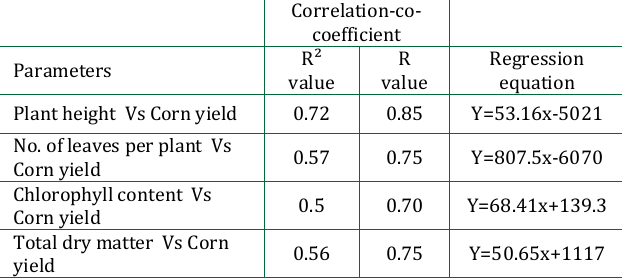
Table 2: Correlation -co- efficient and regression equation for growth parameters with yield of baby